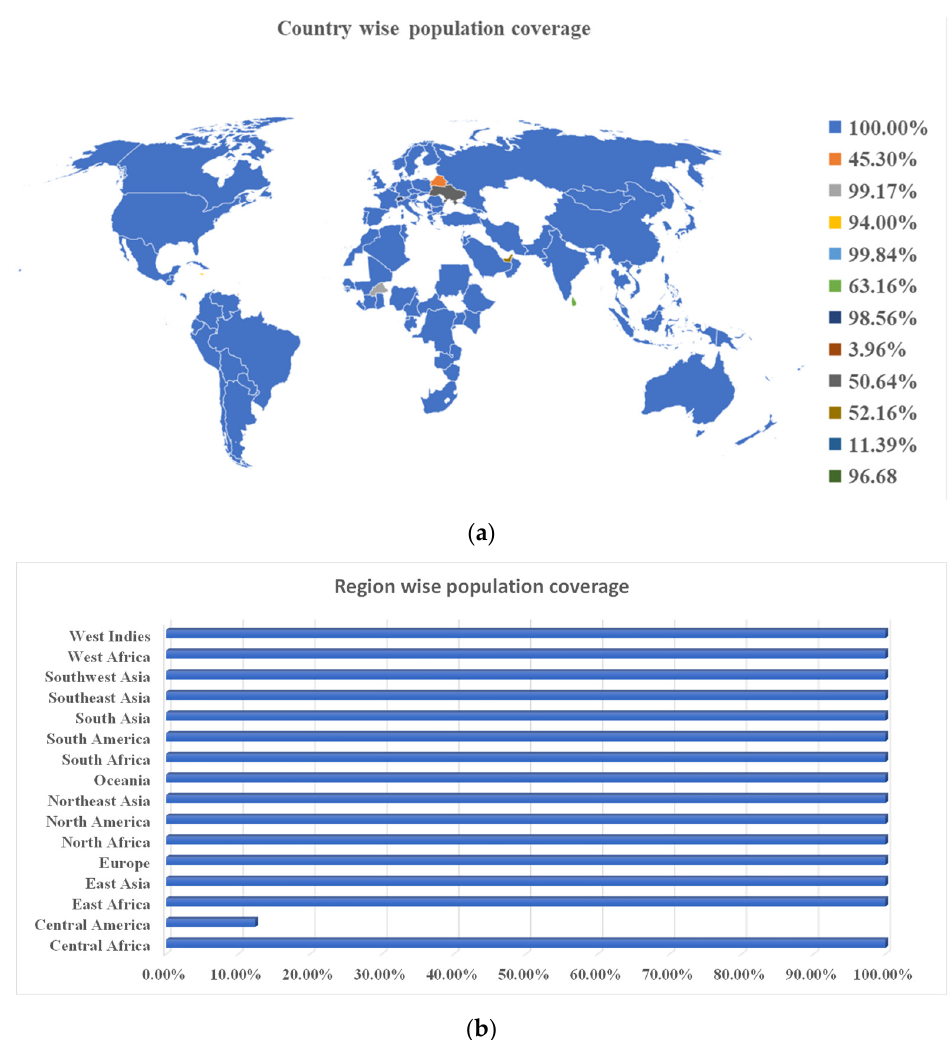
Figure 2. ( a ). Country-wise population coverage for selected epitopes ranges from the lowest 11.39% (Wales) to 100% (Pakistan, Indonesia, China, India, United States of America, and most of the populous countries). ( b ). Region-wise population coverage for the selected T cell epitopes ranging from the lowest 12.38% (Central America) to 100% in all other regions across the globe.